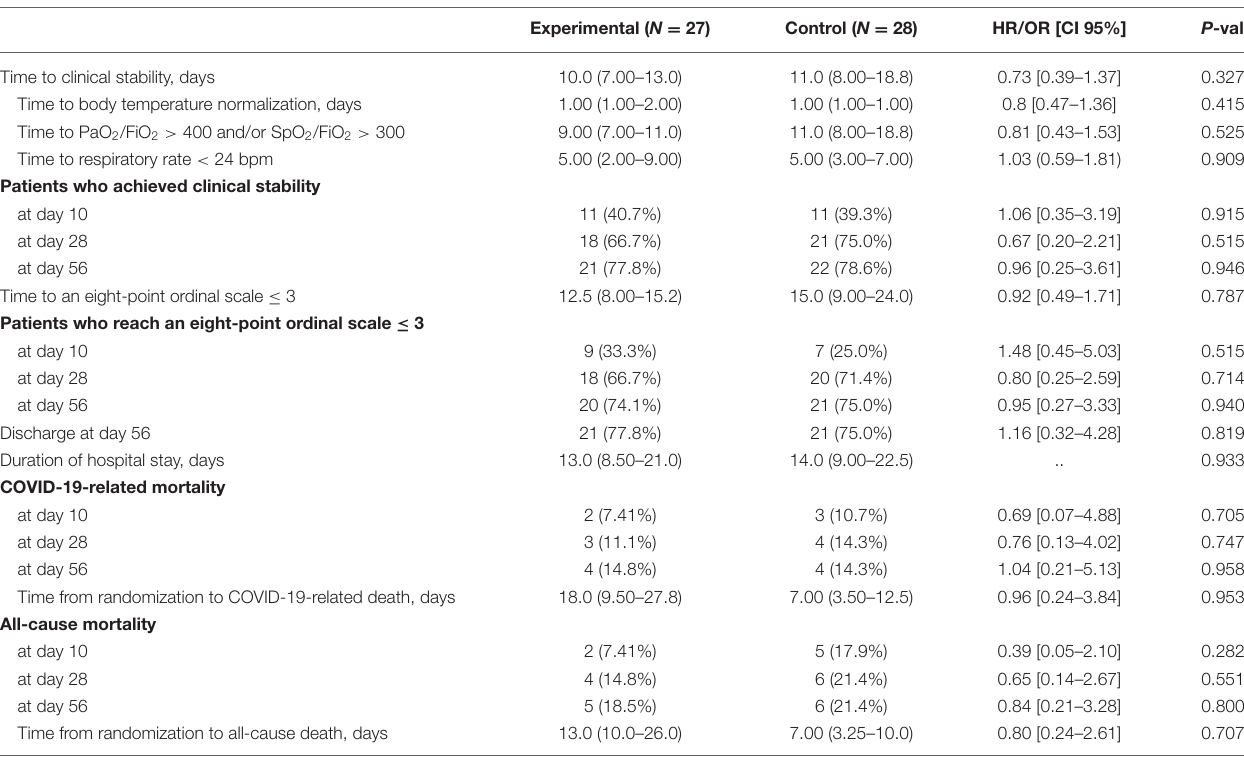
TABLE 3 | Effect of allocation to experimental group on key study